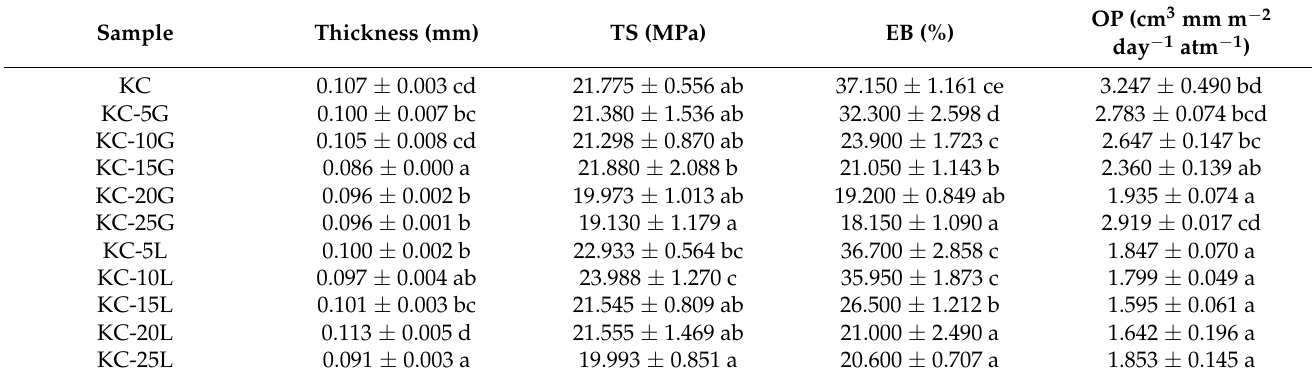
Table 1. TS and EB of KC, KC-G and KC-L films.